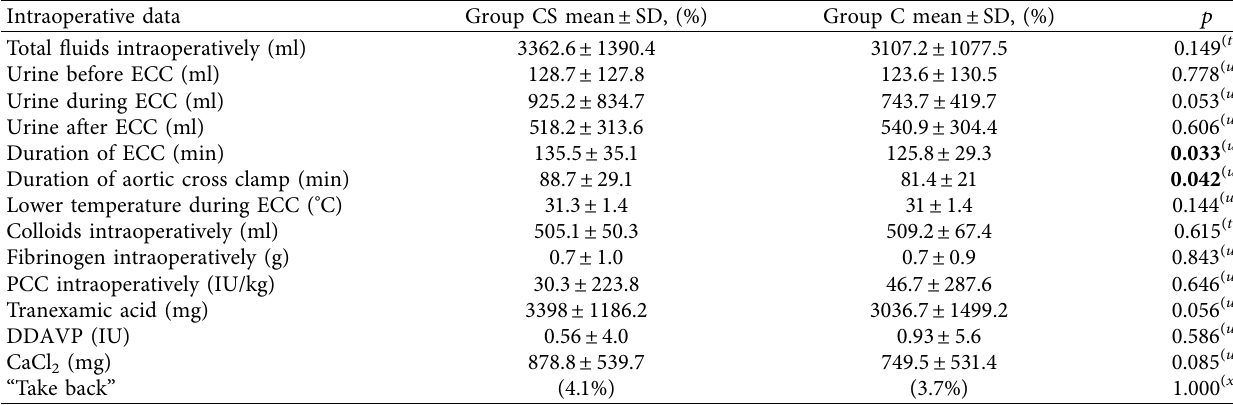
The bold values indicate significantly different at p < 0.05. Table 3: Cell salvage specimens’ analysis (A: before centrifugation, B: after centrifugation, ( a ) : ANOVA repetitive measures test). Parameter